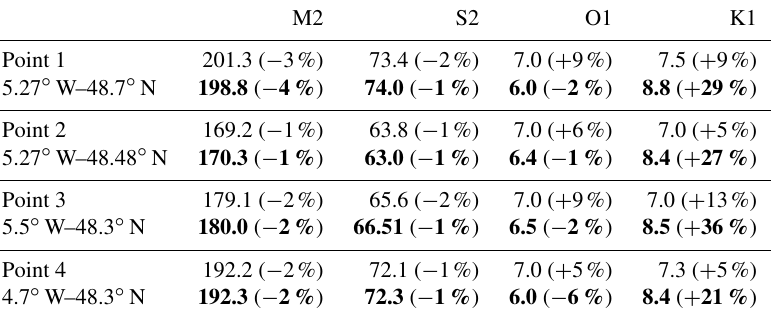
Table 3. Comparison of the wave elevation amplitudes between MARS3D one-way (roman font) and MARS3D-AGRIF two-way (bold font) for the Iroise magnification (500m horizontal resolution). The model amplitudes are given in centimeters, with the relative difference between model and observation given in